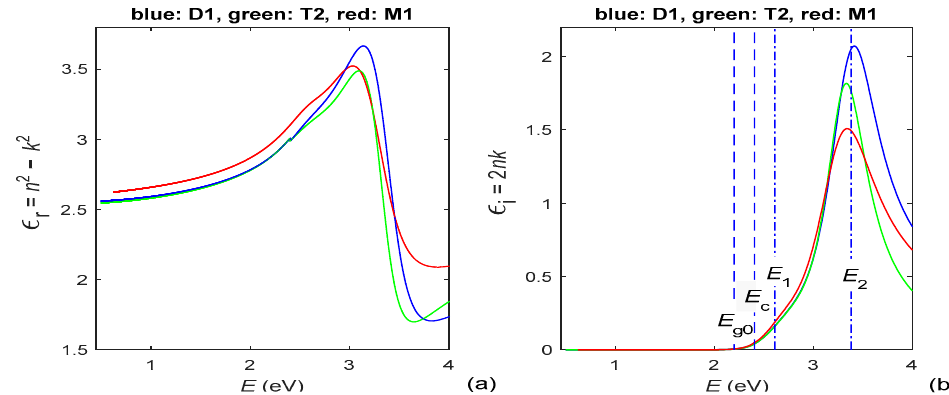
Figure 3. ( a ) The real part of the complex dielectric function of the PAZO polymer films ; ( b ) the imaginary part of the complex dielectric function of the same films.